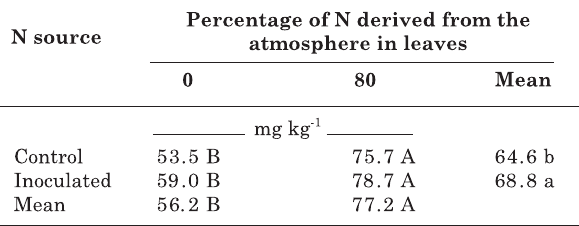
Table 3. Contribution of biological N of N derived from the atmosphere) in leaves of common bean plants at 41 days after emergence, grown at two levels of P applied to the soil (0 and 80 mg kg -1 ) and two N sources (control without N and inoculated with rhizobia); means of two P and two Mo concentrations in sowing